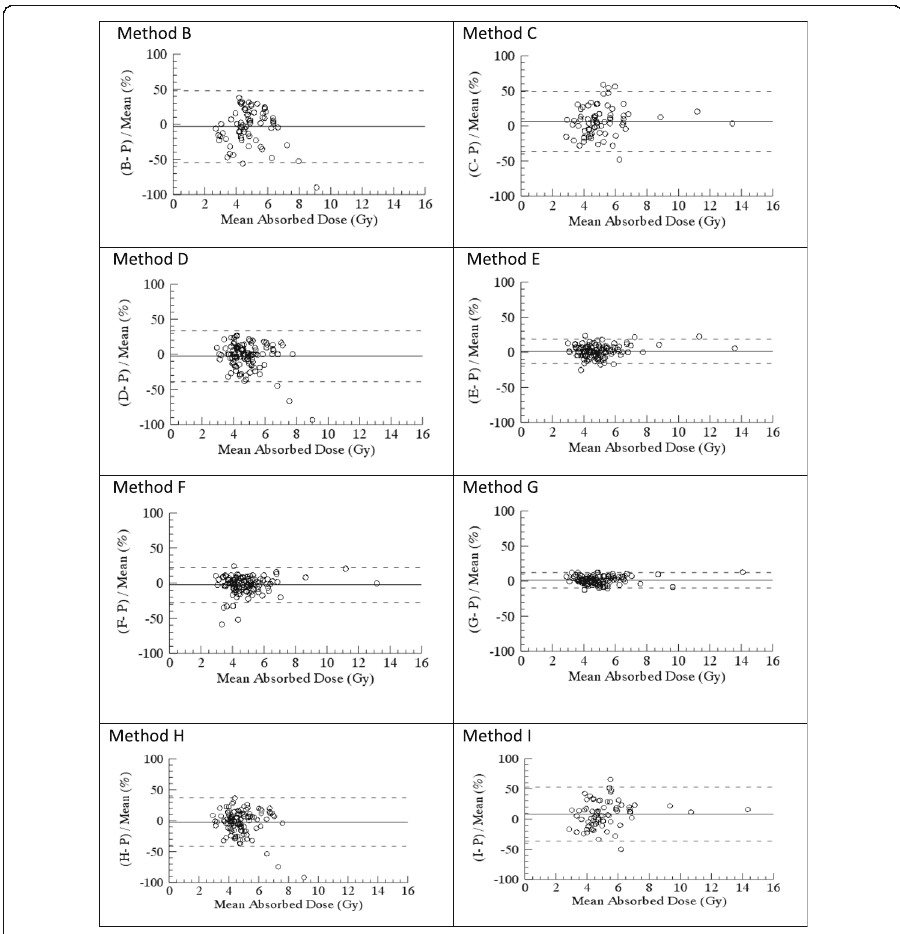
Fig. 3 Pairwise quantification (Bland-Altman plots) of the limits of agreement (LOAs, dashed lines) of the relative AD difference for the alternative dosimetry protocols (B – I). The AD/cycle from each method is compared to that of method P (hybrid dosimetry in every treatment cycle, as per protocol) and normalized to the mean of the two methods. B : Planar dosimetry first cycle only (2SD=51%). C : Planar dosimetry in all cycles (2SD=43%). D : Hybrid dosimetry first cycle only (2SD=36%). E : Hybrid dosimetry cycle one, and one SPECT/CT at 24 h in the following cycles (2SD=17%). F : One SPECT/CT at 24 h in each cycle and constant half-time (2SD=25%). Methods G, H and I are all based on Eq. 8 (see the “ Methods ” section). G : One SPECT/CT at 96 h in all cycles (2SD=11%). H : One SPECT/CT at 96 h first cycle only (2SD=39%). I : Planar dosimetry at 96 h in all cycles